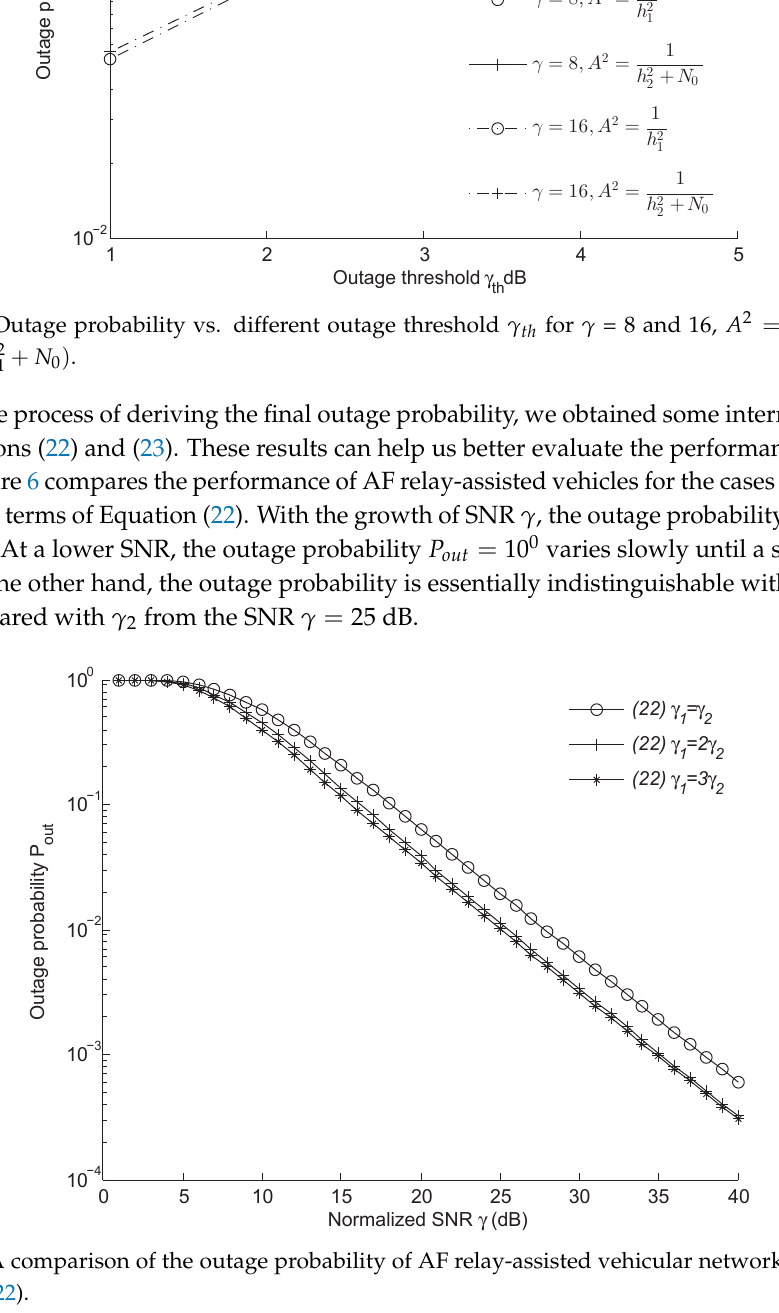
Figure 6. A comparison of the outage probability of AF relay-assisted vehicular networks based on Equation